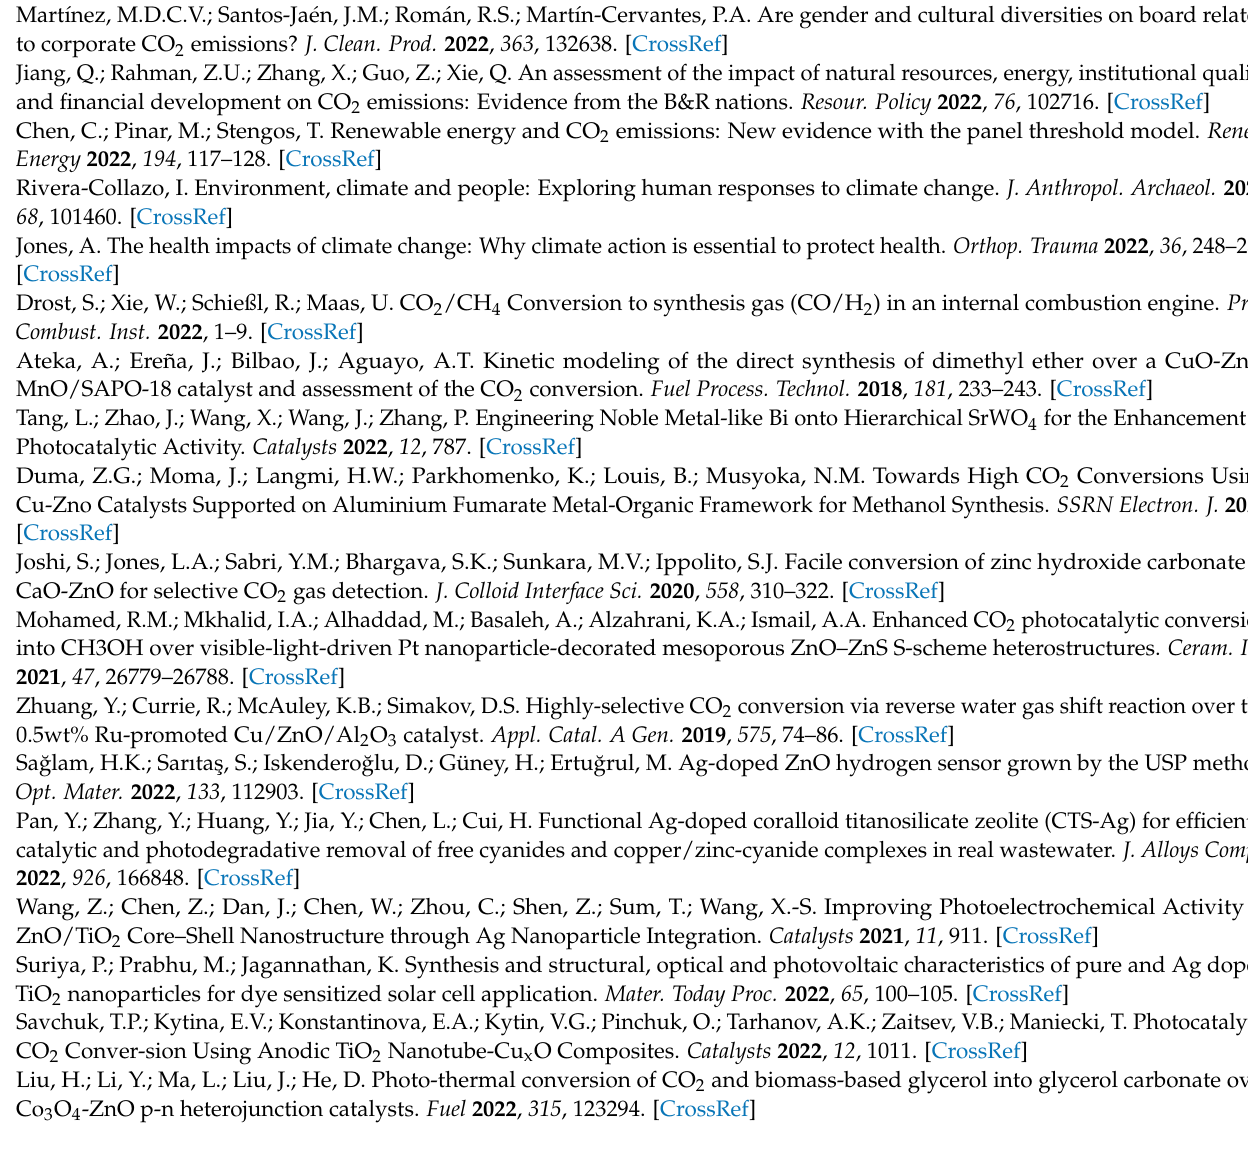
ZnO; Figure S2. Photoluminescence analysis of ZnO and Ag-ZnO; Figure S3. XRD patterns of Ag-ZnO and reused Ag-ZnO photocatalysts; Table S1: The photocatalytic CO 2 conversion of different photocatalysts